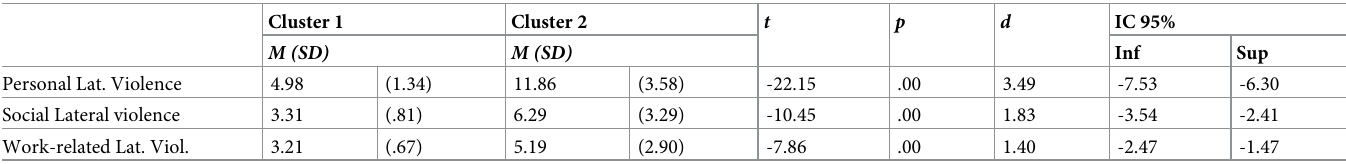
Table 3. Means, SD and ANOVAs of the clustering and profiling